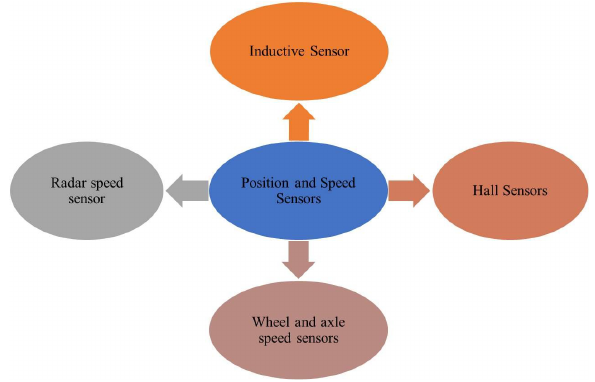
Figure 1: Different speed and position